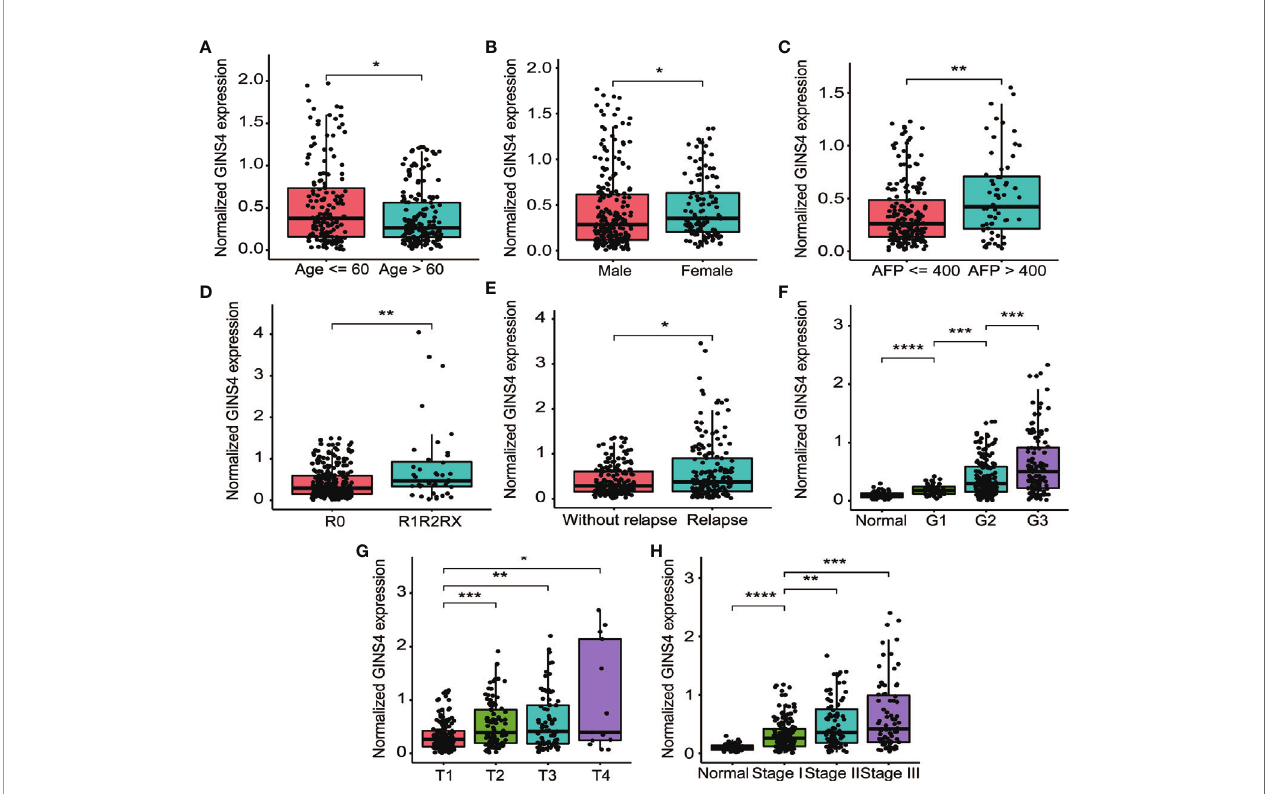
FIGURE 5 | GINS4 mRNA level is signi fi cantly correlated with multiple clinicopathologic parameters in 371 HCC cases from the TCGA database. GINS4 mRNA level in HCC patients strati fi ed by (A) age, (B) gender, (C) AFP level, (D) residual tumor, (E) relapse, (F) histologic grade, (G) T classi fi cation, and (H) TNM stage. (*P < 0.05, **P < 0.01, ***P < 0.001, and ****P <